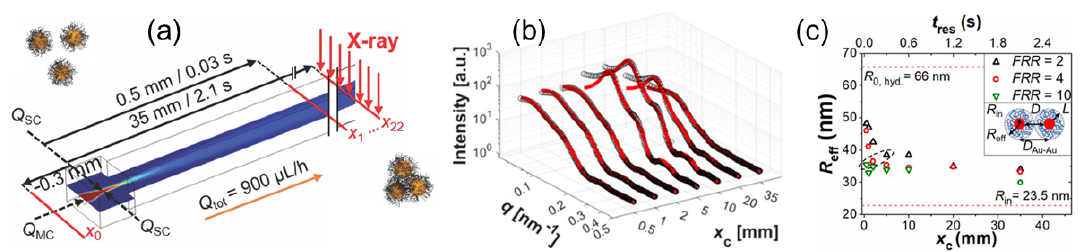
Figure 15. Probing the hydrophobic collapse of grafted polystyrene chains on gold nanoparticles in THF upon mixing with water. Initially, repulsive particles became attractive and clustered upon collapse of the grafted chains. ( a ) Schematic representation of the 3D flow-focusing microfluidic reactor with a middle channel (MC) and two side channels (SC), and the simulated concentration pattern of THF/water mixture. The X-ray beam passed orthogonal to the flow and the lateral focusing directions. ( b ) Evolution of the SAXS profiles of the particles as a function of the distance from the mixing point ( X C ) for a flow rate ratio (FRR) of 2. The peak corresponds to the structure factor of the particles upon clustering and modeling of which provided an effective size of particles. ( c ) The variation of effective particle radius as a function of X C , which is equivalent to a residence time ( t res ) given by the flow rate, for different FRR. The chain collapse transition occurred in the millisecond time scale. Adapted from